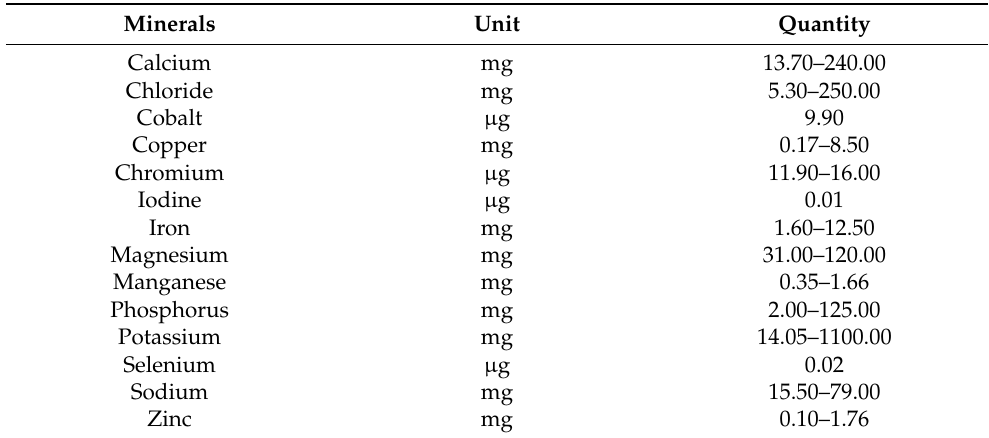
Table 2. Minerals in NCS [19,23].